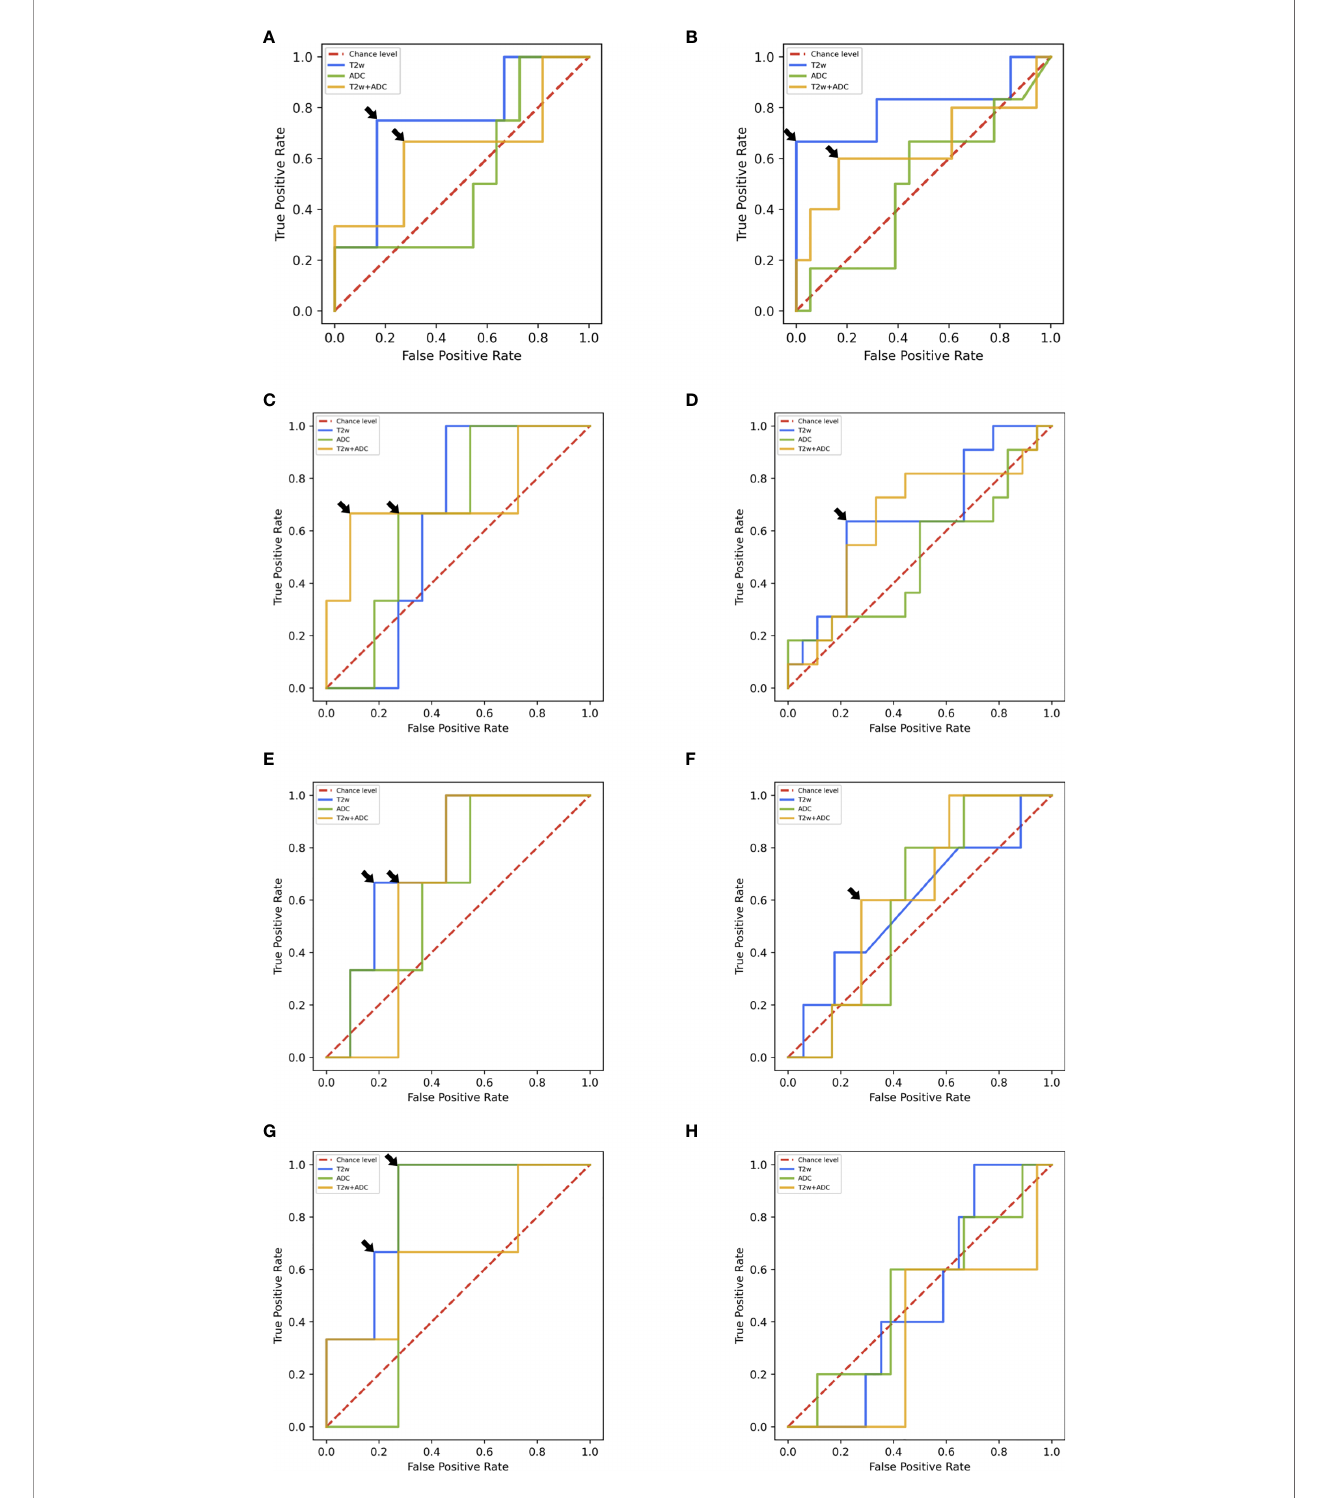
FIGURE 5 | (A) ROC curves of ML frameworks on the test set 2.0. (B) ROC curves of ML frameworks on the multi PI-RADS test set. (C) ROC curves of DL AG-free CNN trained on L-DS test set 2.0. (D) ROC curves of DL AG-free CNN trained on L-DS multi PI-RADS test set. (E) ROC curves of DL AG-free CNN trained on C-DS test set 2.0. (F) ROC curves of DL AG-free CNN trained on C-DS multi PI-RADS test set. (G) ROC curves of DL AG CNN trained on C-DS test set 2.0. (H) ROC curves of DL AG CNN trained on C-DS multi PI-RADS test